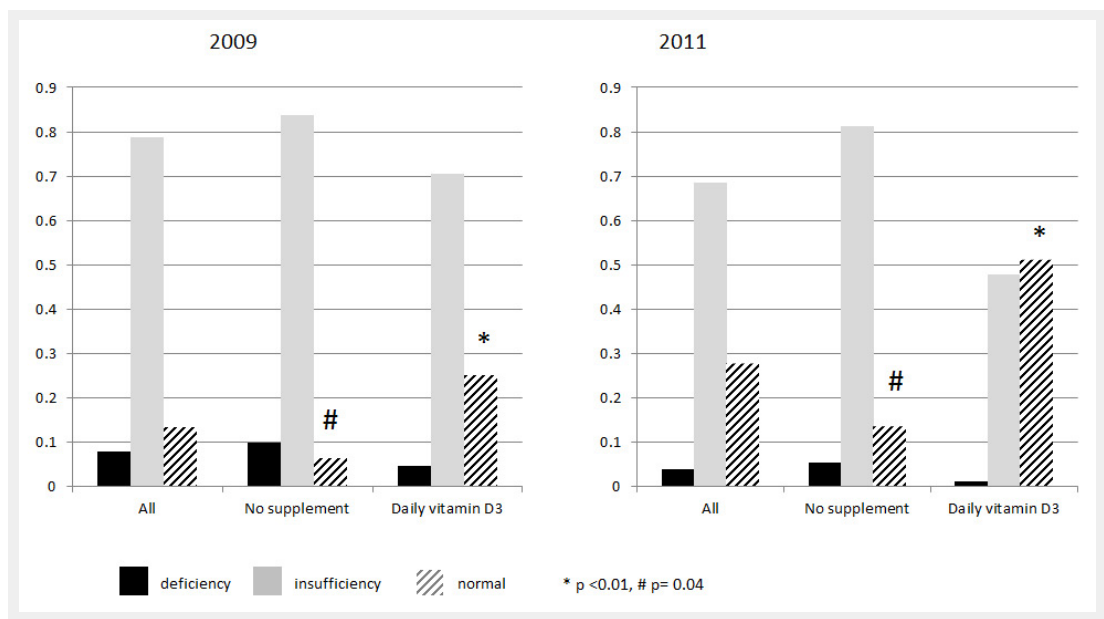
Figure 2 Effects of vitamin D3 supplementation: X-axis: 3 groups: all patients, nonsupplemented patients and patients with daily supplement of vitamin D3; Y-axis: percentage of patients with deficiency, insufficiency or normal results (1 = 100%); * and #: comparison between 2009 and 2011, the number of patients with normal results being significantly higher in